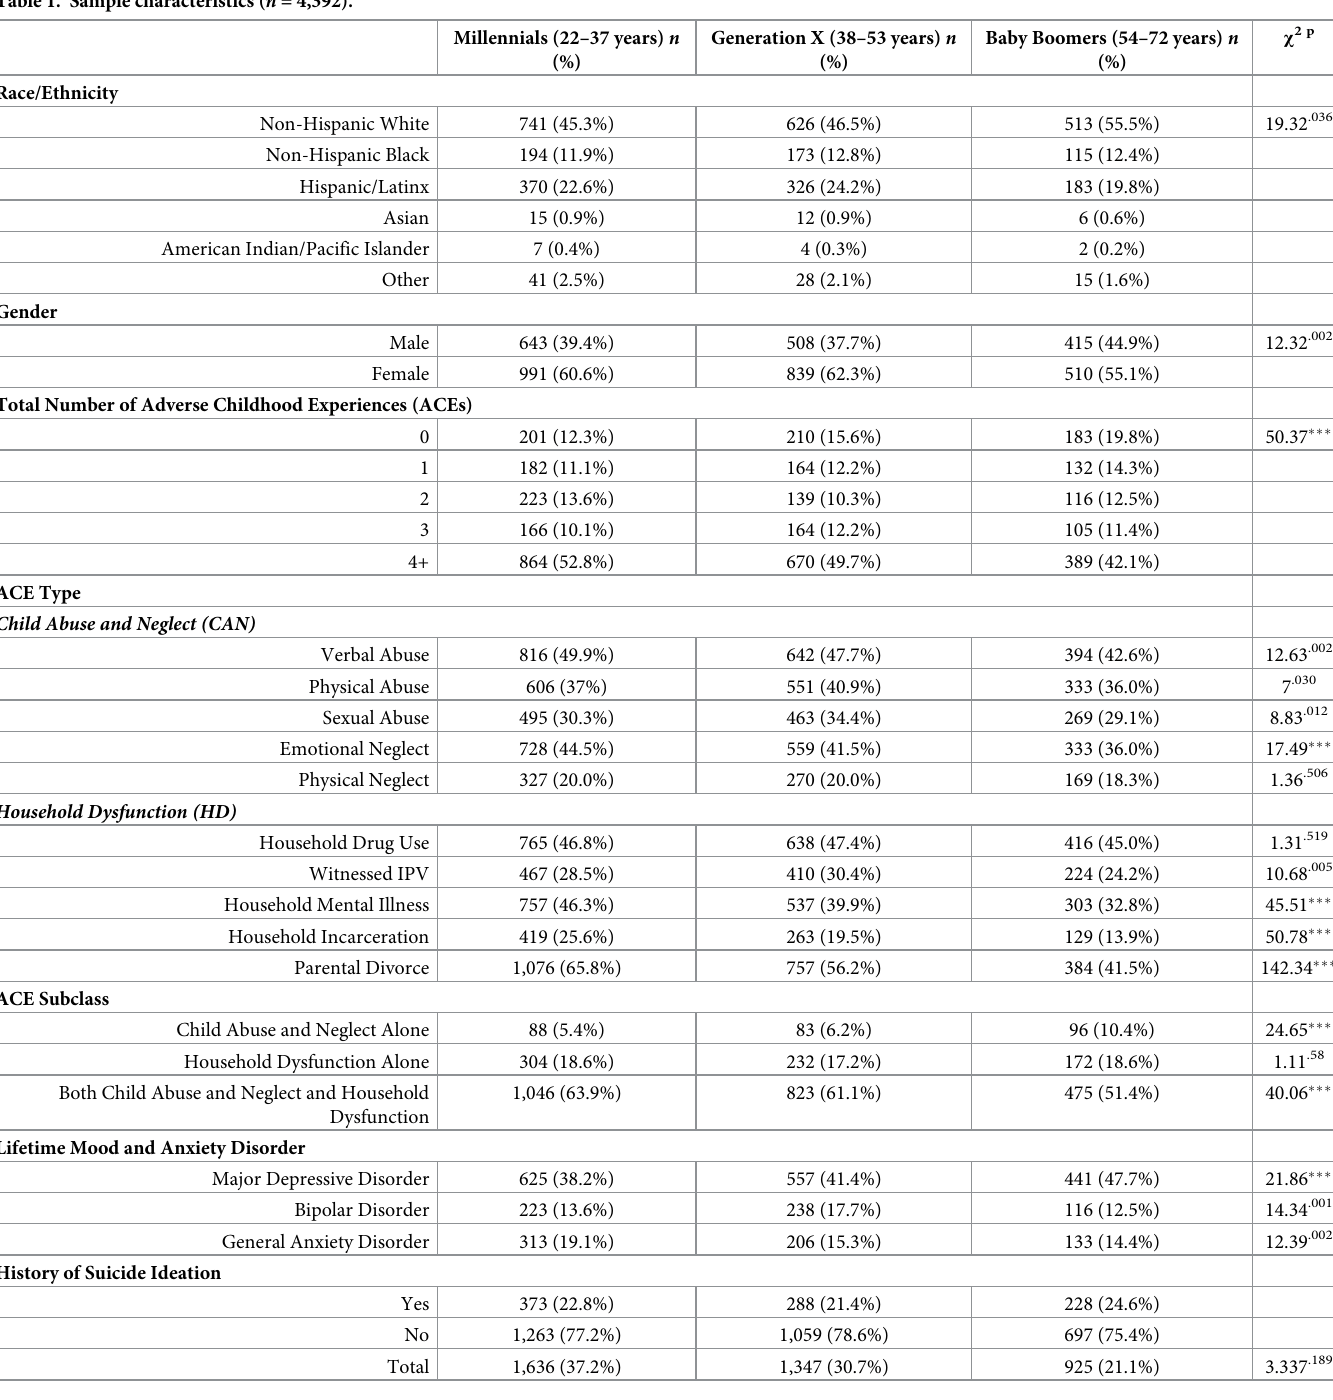
Table 1. Sample characteristics ( n =